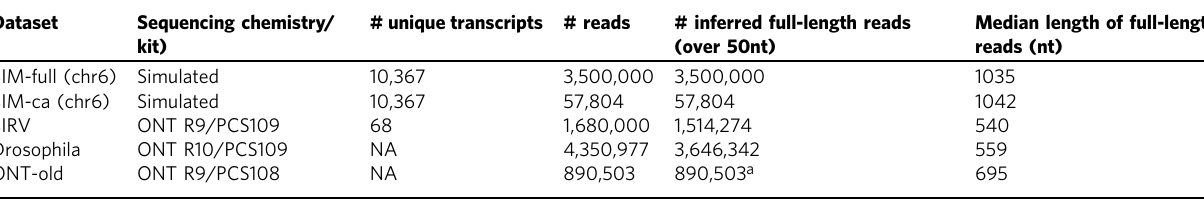
Table 1 Datasets used in evaluation of the transcriptomic Oxford Nanopore Sequencing datasets.